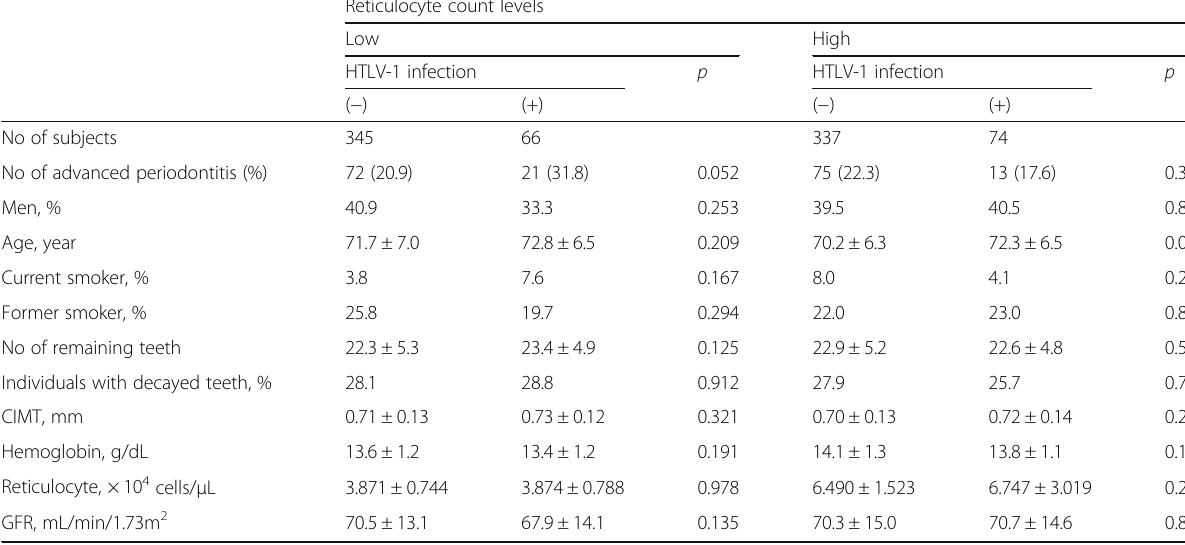
Table 1 Characteristics of study population Reticulocyte count levels Low High